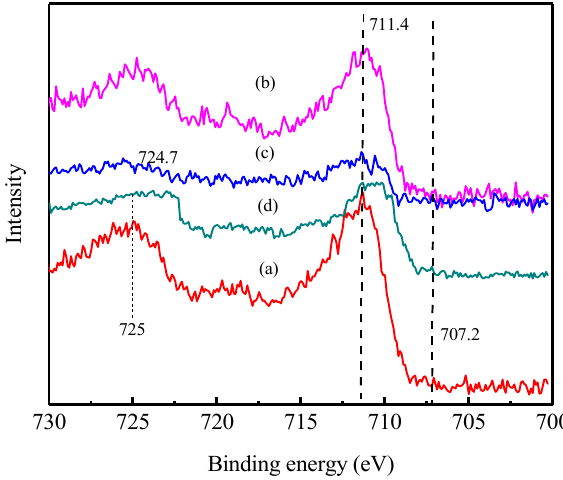
Figure 6. XPS spectroscopy of Fe 2p for fresh PPG-nZVI beads ( a ) and for PPG-nZVI beads reaction with Pb 2+ ( b ), Cu 2+ ( c ), and Zn 2+ ( d ).